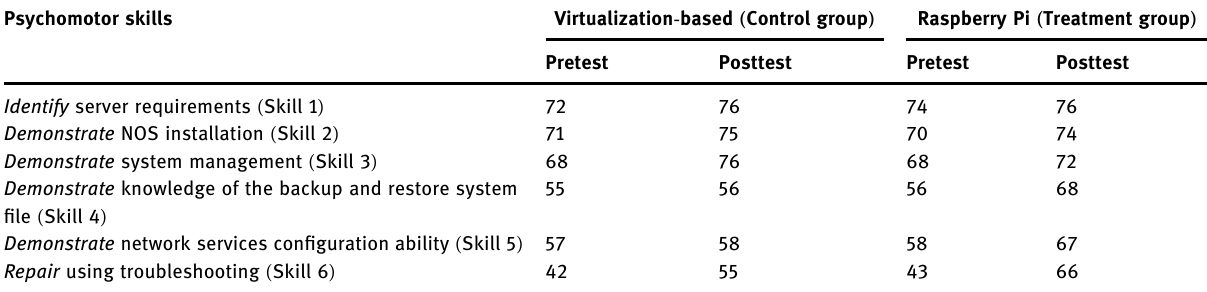
Table 2: Comparison of control group and treatment group Psychomotor skills